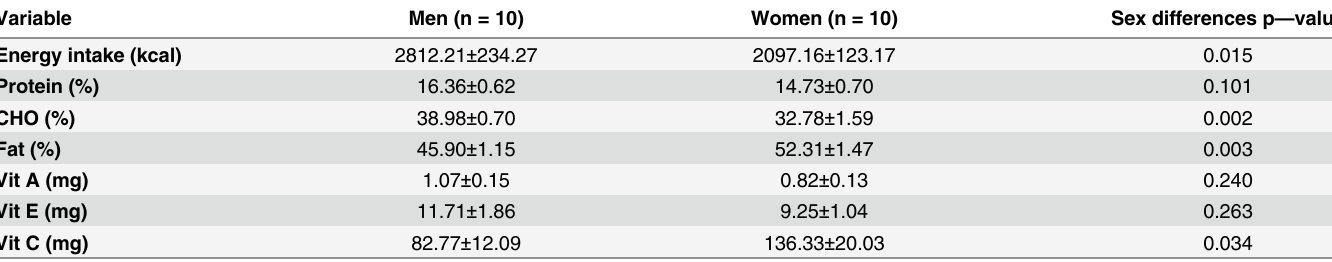
Table 1. Overview of participants ’ daily diet.